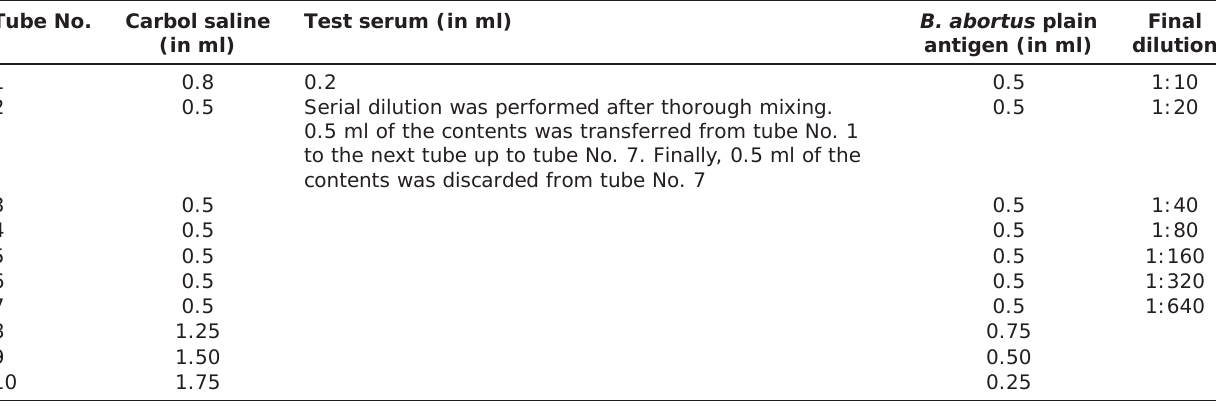
Table-1: STAT protocol. Tube